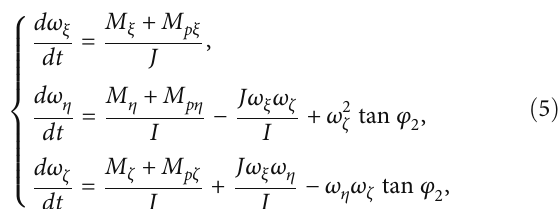
Figure 1: Projectile structure schematic for the uncorrected con fi guration.